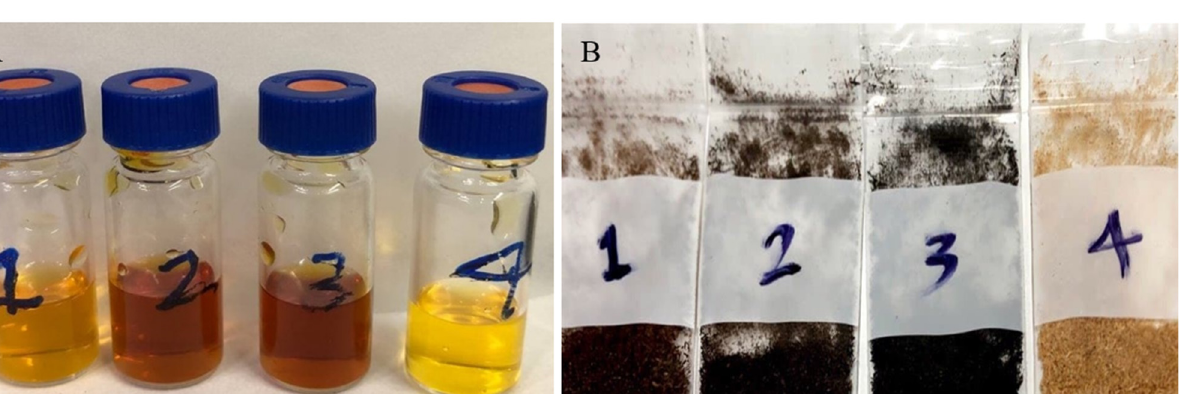
Figure 6. Proximate analysis ( A ) and oxygen/carbon, hydrogen/carbon ratios of wood sawdust be- fore and after torrefaction ( B ).